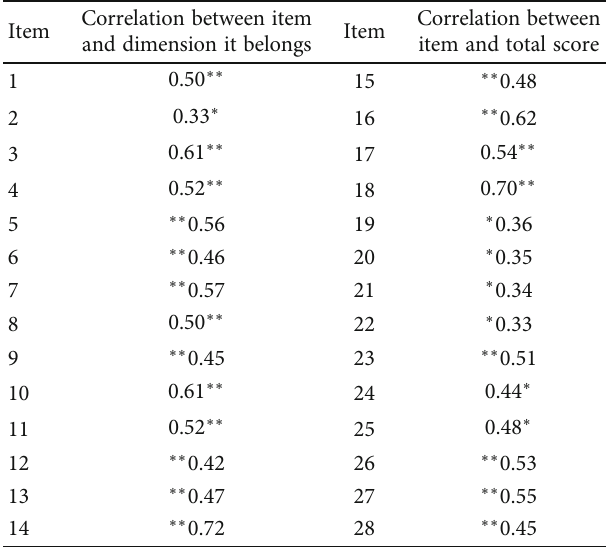
Table 2: The values of Person correlation coe ffi cients between items and the overall score.